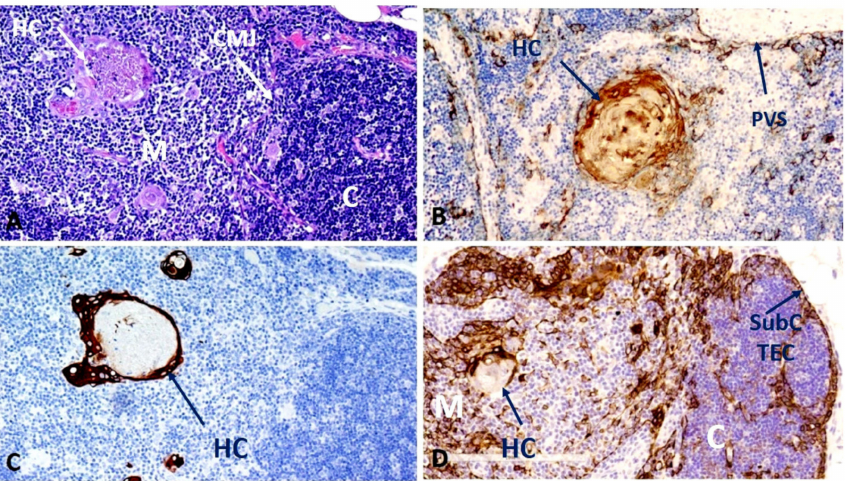
Figure 2. ( A ) shows a low magnification view of the normal thymus stained with H&E; a prominent cystic HC full of keratinic debris is clearly visible; CMJ is indicated at the interface C–M; ( B ) staining with CK AE1/AE3: the peripheral part of a Hassall Corpuscle (HC) is stained, as well as scattered EC in the cortex and medulla. PVS bordered by a TEC lining is shown; ( C ) CK10 staining of the peripheral part of HCs. C: courtesy of Prof. Marx and of Prof. Ströbel, Mannheim/Göttingen, Germany); ( D ) The cytokeratin antibody CK5/6 is considered a marker of a basal-layer type of CK, found in the early stages of epidermal keratinocyte differentiation. In addition to scattered TEC in the cortex and medulla, a prominent staining of subcapsular TEC bordering the cortical lobules is clearly visible. Modified from Ramieri M.T., and colleagues [26]. HC: Hassall’s corpuscle; M: Medulla; C: cortex; CMJ: corticomedullary junction; PVS: perivascular space; SubC TEC: subcapsular Thymic epithelial